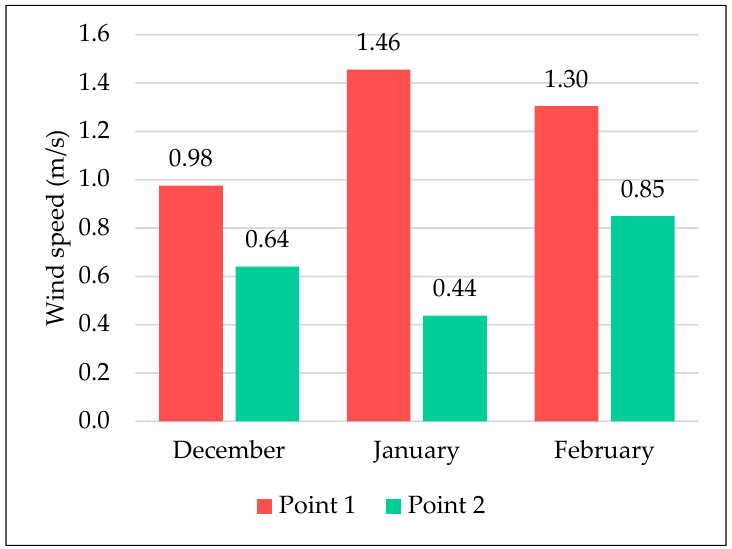
Figure 5. Monthly average wind speed at both points. Table 8. Correlation coefficient between PMs and wind speed at different levels.